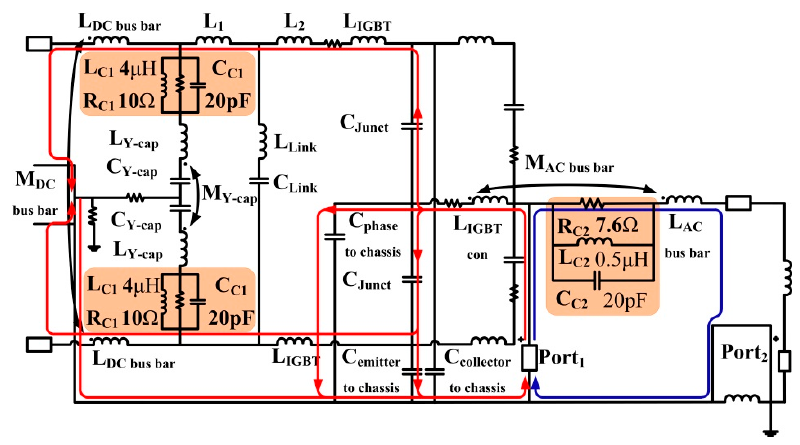
Figure 18. Current ‐ following path after adding CM ferrite chokes through the Y ‐ caps and the AC bus bar. Figure 18. Current-following path after adding CM ferrite chokes through the Y-caps and the AC bus bar. Energies 2016 , 9 , 419